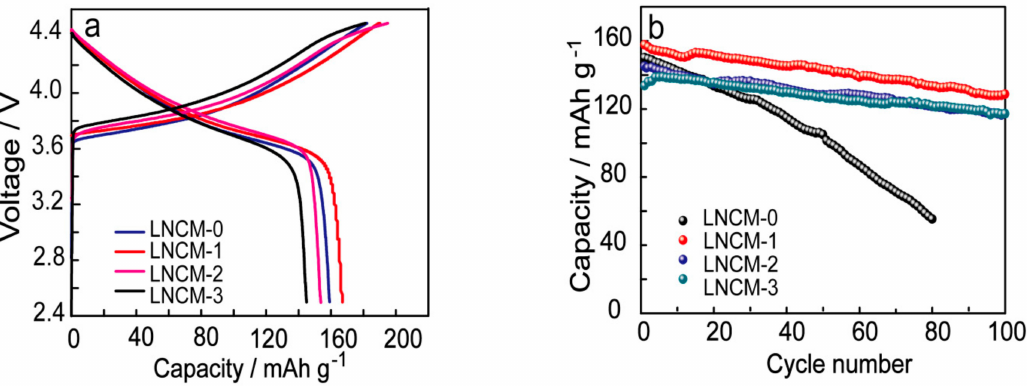
Figure 8. Charge and discharge characteristics of LNCM-0~LNCM-3: ( a ) discharge capacity at 0.17 A · g − 1 , ( b ) cycle performance at 0.34 A · g − 1